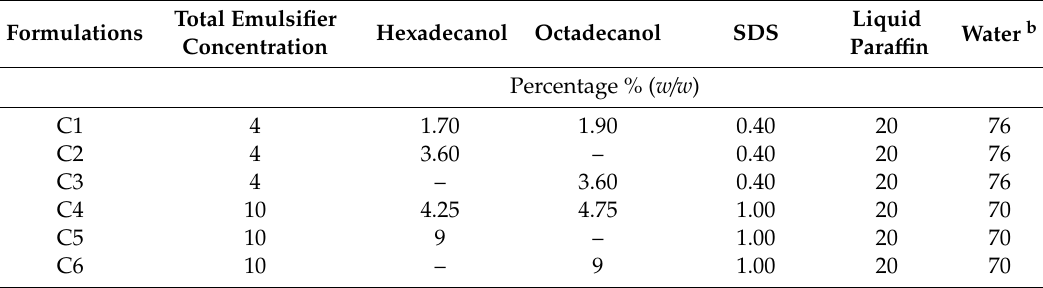
Table 1. Chemical composition of aqueous creams (C1–C6) a